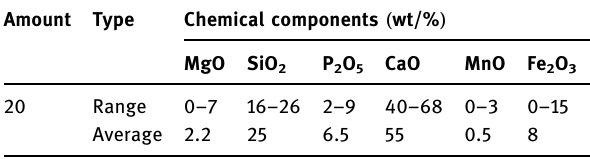
Table 4: Composition of phase C